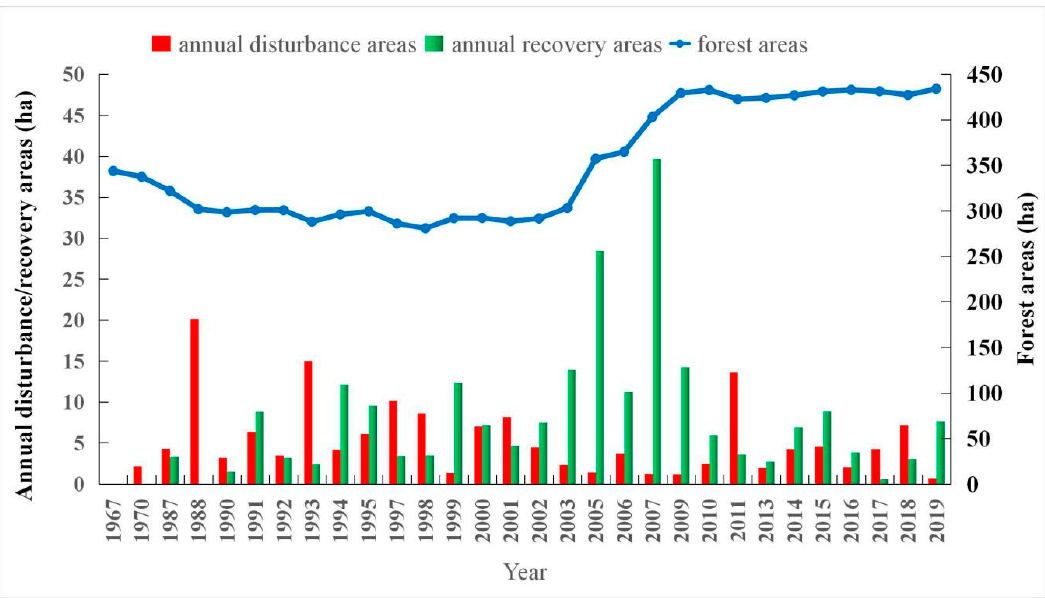
Figure 6. Changes in the forest cover, annual disturbance and annual recovery on Mt. Mufu from visual interpretation and the VCT model applied to the integrated Corona and Landsat data.